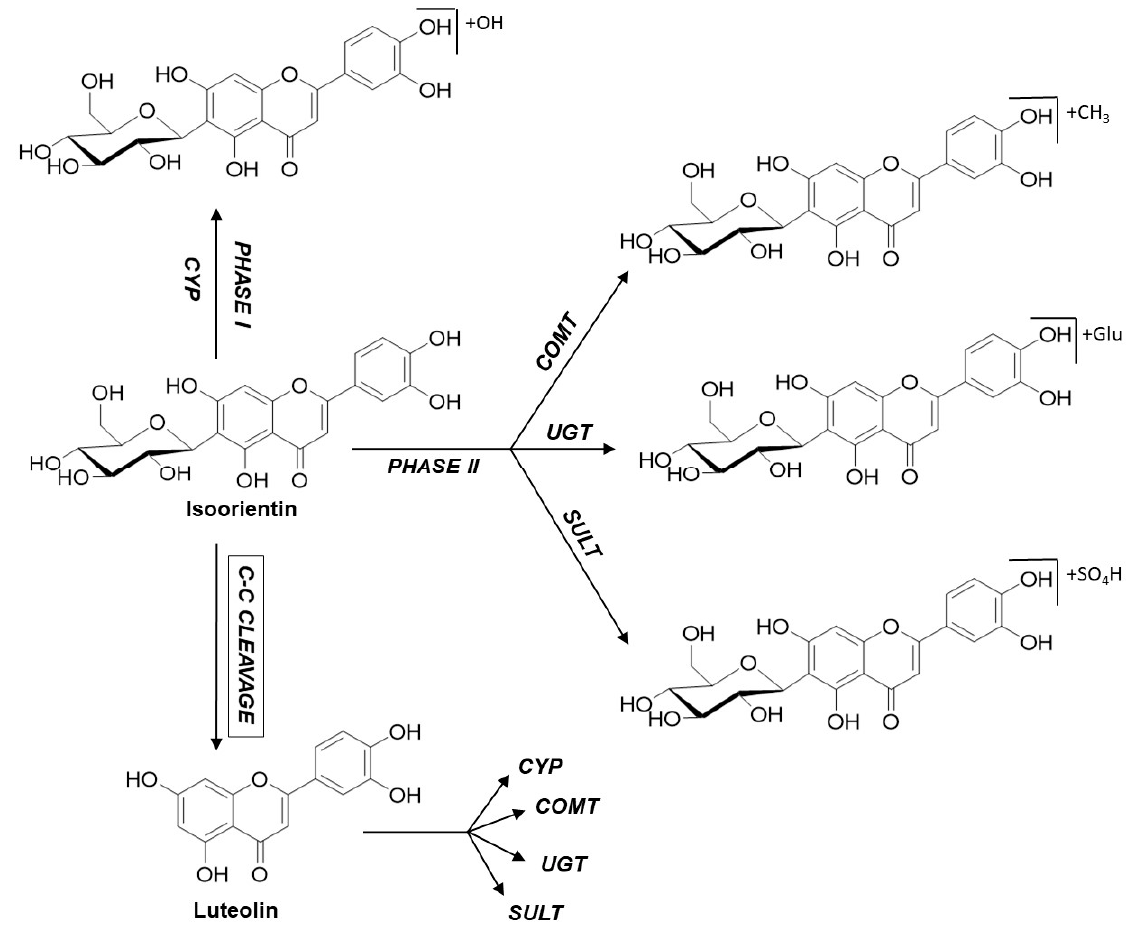
Figure 5. Metabolism pathways shown for the example of isoorientin.